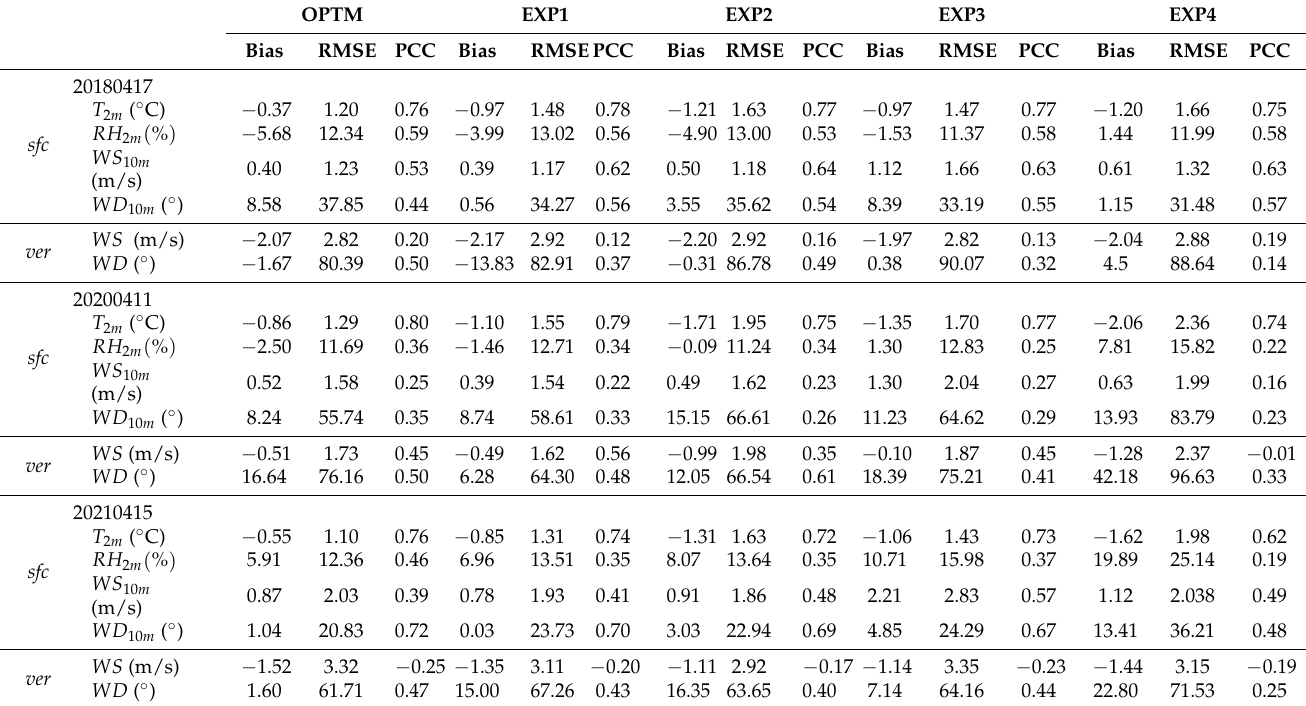
Figure 5. Comparison of the optimized vs. non-optimized experiments using the normalized RMSE for ( a ) all variables based on Equation (1), ( b ) surface variables based on Equation (2), and ( c ) winds at given vertical levels based on Equation (3), on 17 April 2018, 11 April 2020, and 15 April 2021, respectively. Table 5. Statistics of surface variables ( sfc ) and winds at vertical levels ( ver ) from the experiments. Statistical indicators include bias, root mean square error (RMSE), and Pearson’s correlation coefficient